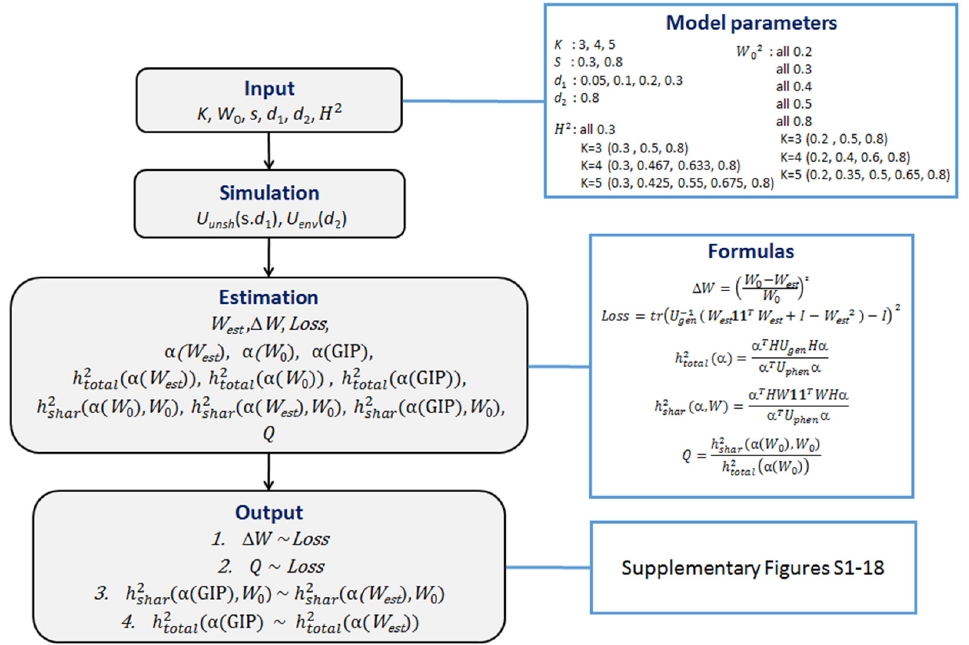
Figure 2. A schematic depicting the overall workflow of a simulation study. All details are given in the text.